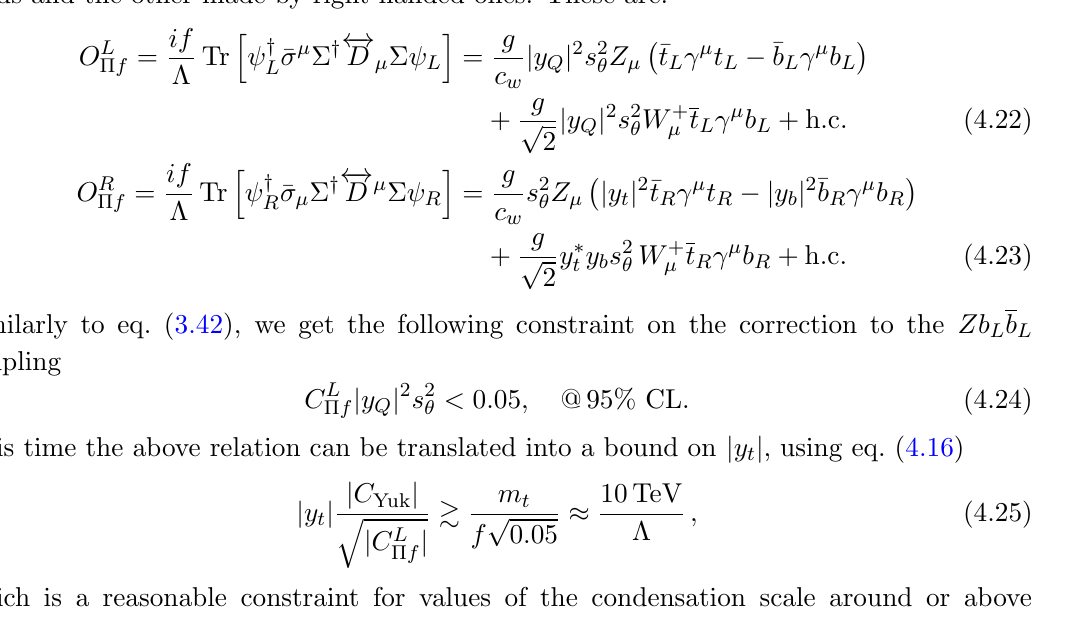
Figure 1 . Diagrams corresponding to the operators O 1 e(cid:11)ective potential of the pNGBs, at the lowest order in the chiral